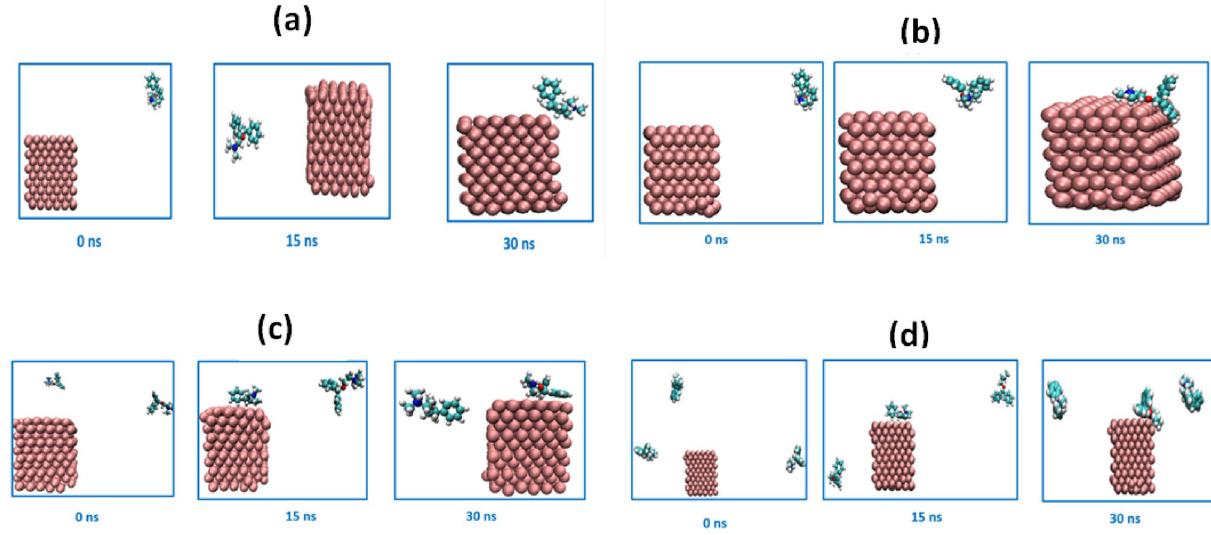
Figure 14. The snapshot of adsorption of DPH on the MS crystal at 250 ppm ( a ), 500 ppm ( b ), 750 ppm ( c ), and 1000 ppm ( d ) concentrations during simulation time. The carbon, nitrogen, hydrogen, oxygen, and iron are shown with cyan, blue, white, red, and purple vdW spheres, respectively. The water and acid molecules were eliminated for the clarity of the plot. The adsorption of DPH molecules on iron at 250 ppm. 500 ppm, 750 ppm, and 1000 ppm concentrations are shown in Videos S1, S2, S3, and S4 in the supplementary information,